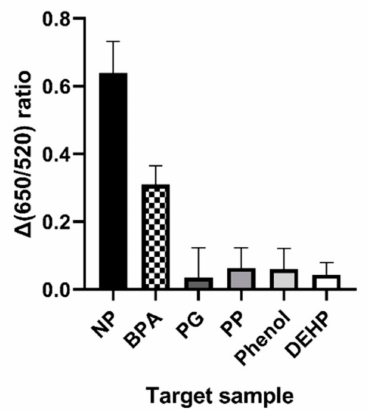
Figure 3. Specificity of NP7 against other endocrine-disrupting chemicals (EDCs) and similarly structured chemicals in the AuNP colorimetric assay. We used 6 endocrine-disrupting chemicals in here; nonylphenol (NP), bisphenol A (BPA), benzylpenicillin (penicillin G, PG), phenylphenol (PP), phenol, and Di-2-ethylhexyl phthalate (DEHP).